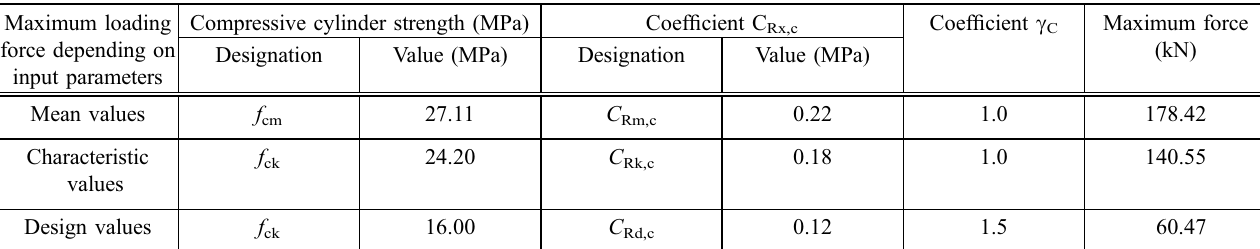
Table 3 Maximum force in press according to the used value of strength with the influence of contact